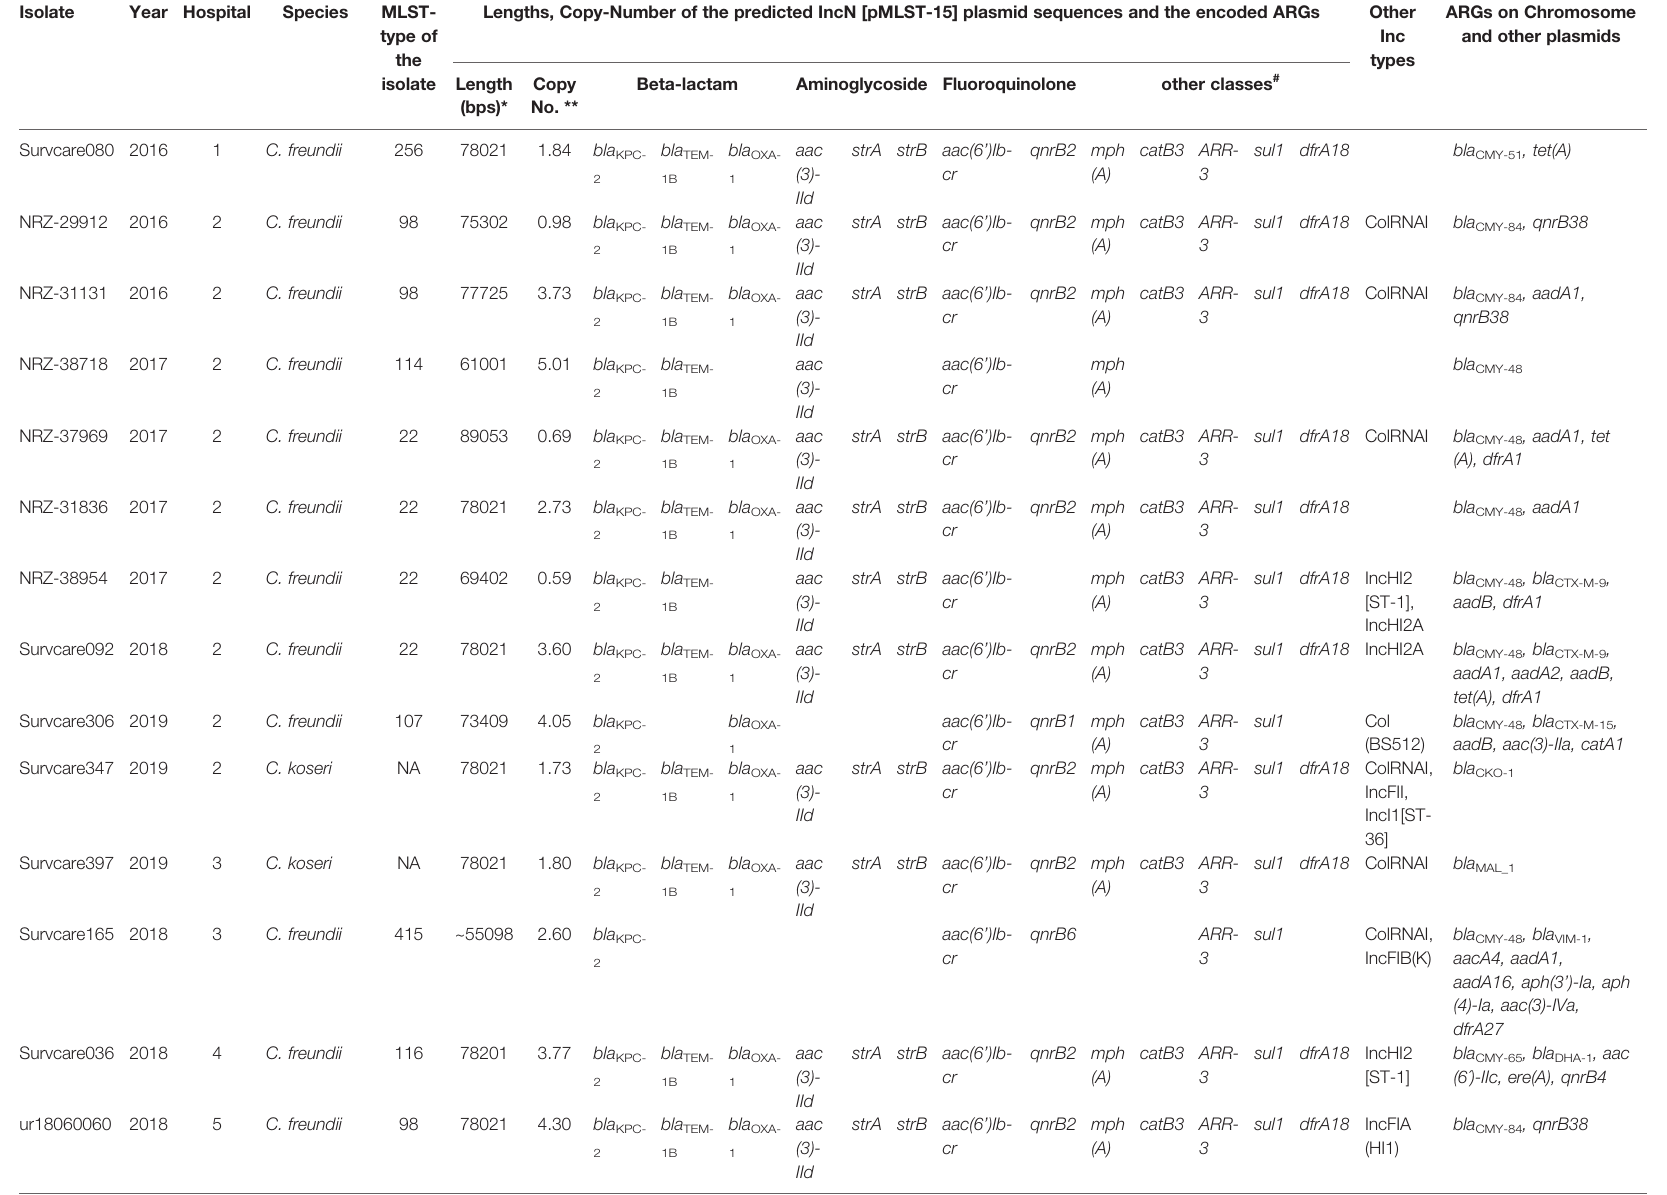
TABLE 3 | Distribution and genetic characteristics of the identi fi ed KPC-2-carrying IncN[pMLST15] plasmids among the Citrobacter spp. Isolates.